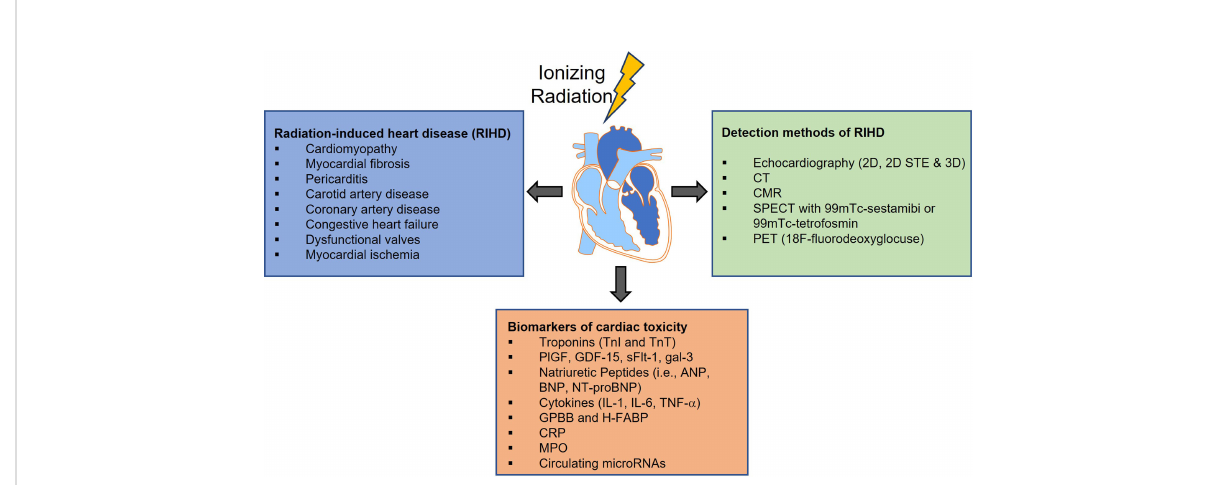
FIGURE 2 Radiation-induced cardiovascular toxicity can manifest as a variety of clinical pathologies. Although the implementation of technological improvements to the radiotherapy (RT) treatment, has led to more precise targeting and has allowed modest increases in RT dose to the tumor, incidental RT to the heart and development of RIHD is still unavoidable. Over the past decades, numerous methods have been developed for cancer therapy-related cardiovascular disease screening and diagnosis, and more particularly for diagnosing radiation-induced injury. However, cardiovascular disease is often diagnosed when damage is irreversible thus the identi fi cation and use of sensitive radiographic and circulating biomarkers to risk stratify or diagnose cardiotoxicity are urgently needed. 2D STE, Two-Dimensional Speckle Tracking Echocardiography; CT, Computed Tomography; CMR, Cardiac Magnetic Resonance imaging; SPECT, Single Photon Emission Computerized Echocardiography;